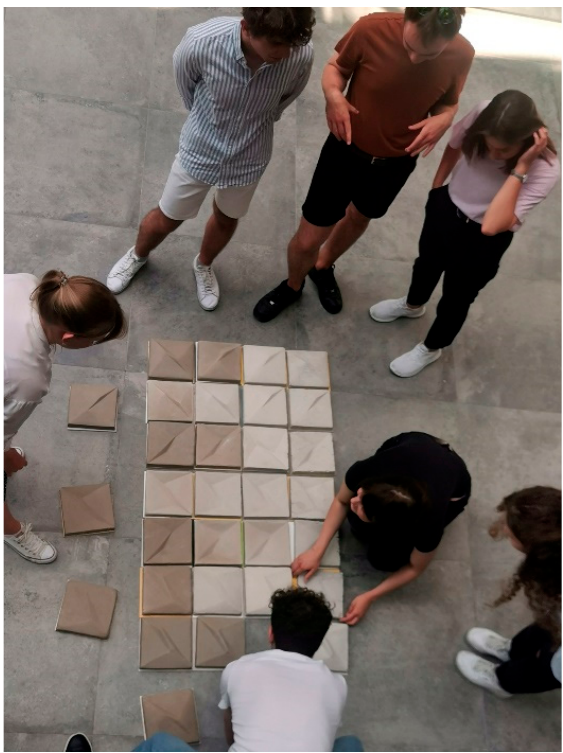
Figure 6. Arranging composition with the wall cladding panels formed in chamotte clay (photo by A.B.).